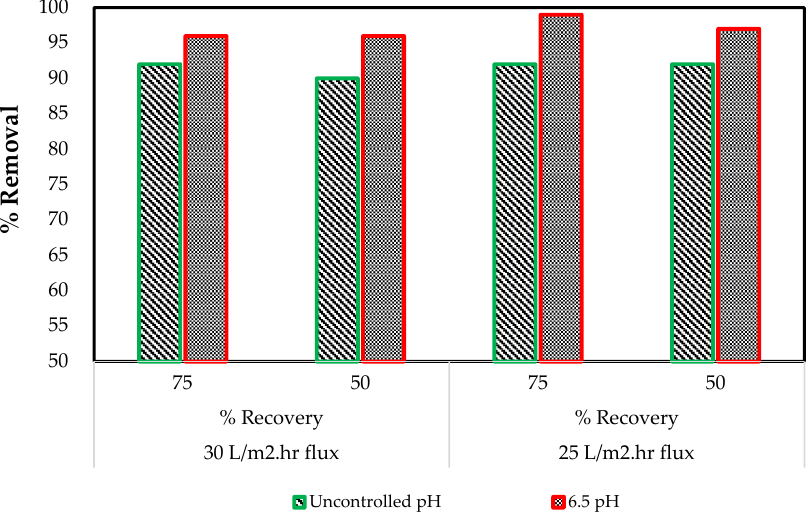
Figure 6. The measured effluents of the RO membrane treatment at uncontrolled and controlled 6.5 pH pilot plant conditions of COD removal.